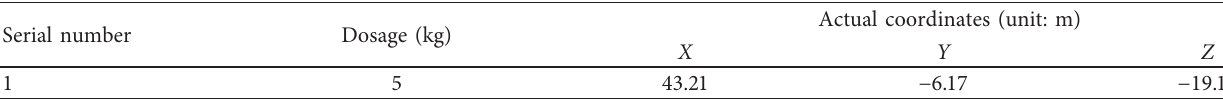
Table 4: Location of the detonation